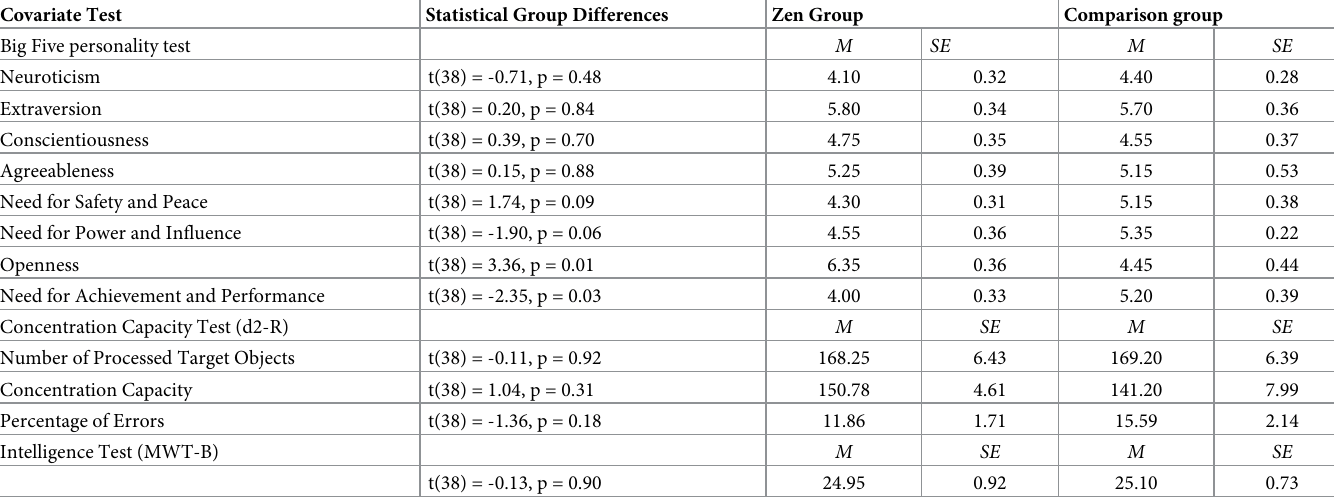
Table 1. Statistical group differences, mean values and standard deviations of covariate